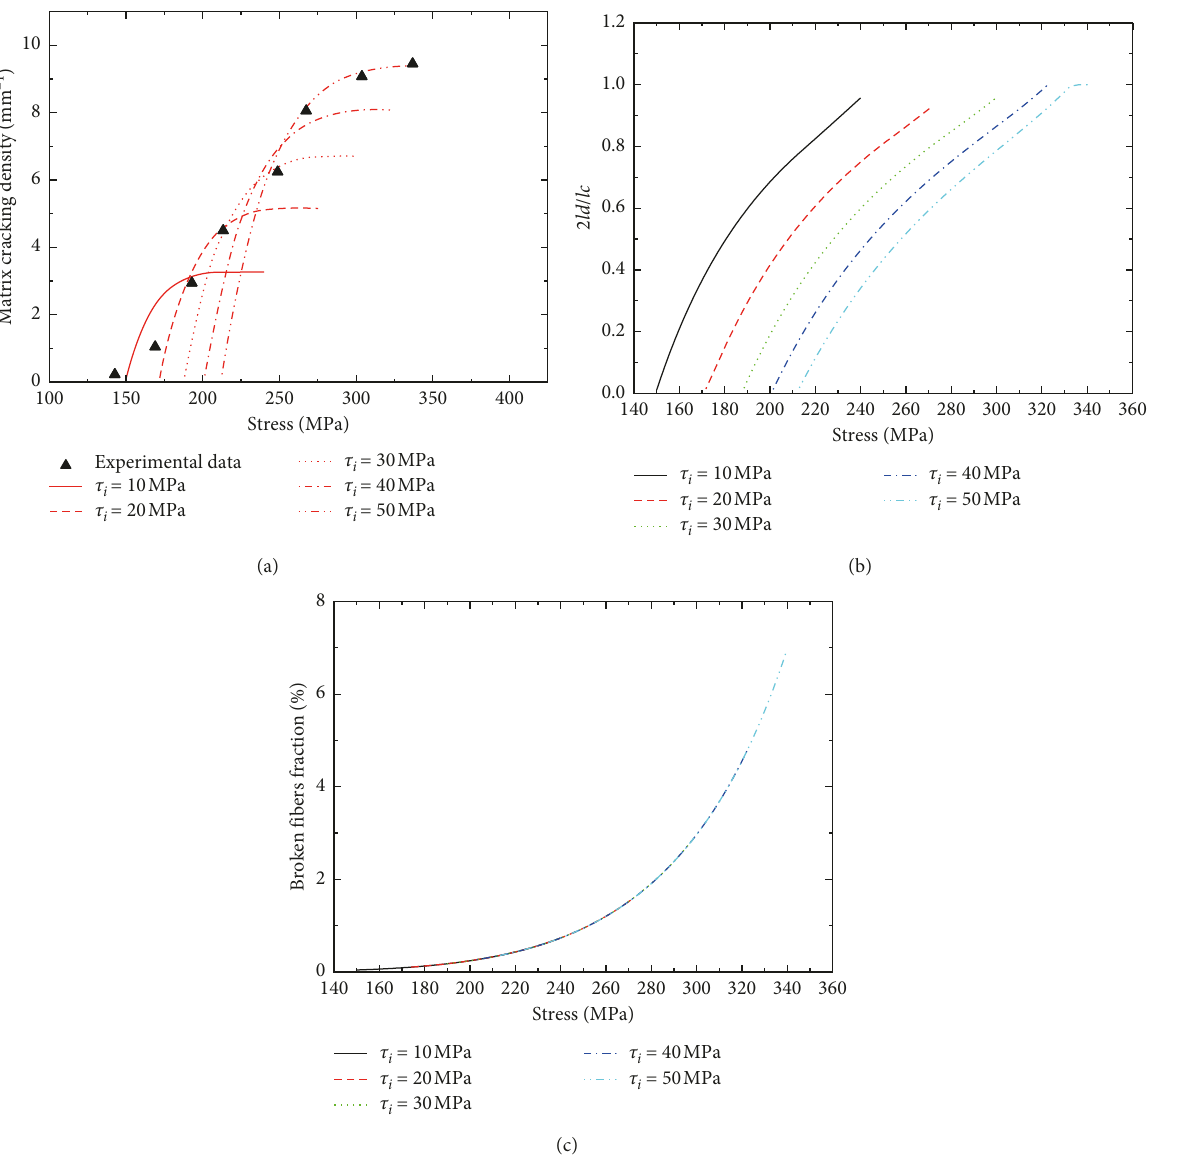
Figure 10: (a) The experimental and predicted matrix cracking density versus the applied stress curves; (b) the interface debonding length versus the applied stress curves; (c) the broken fibers fraction versus the applied stress curves of 2D Sylramic ™ SiC/SiC